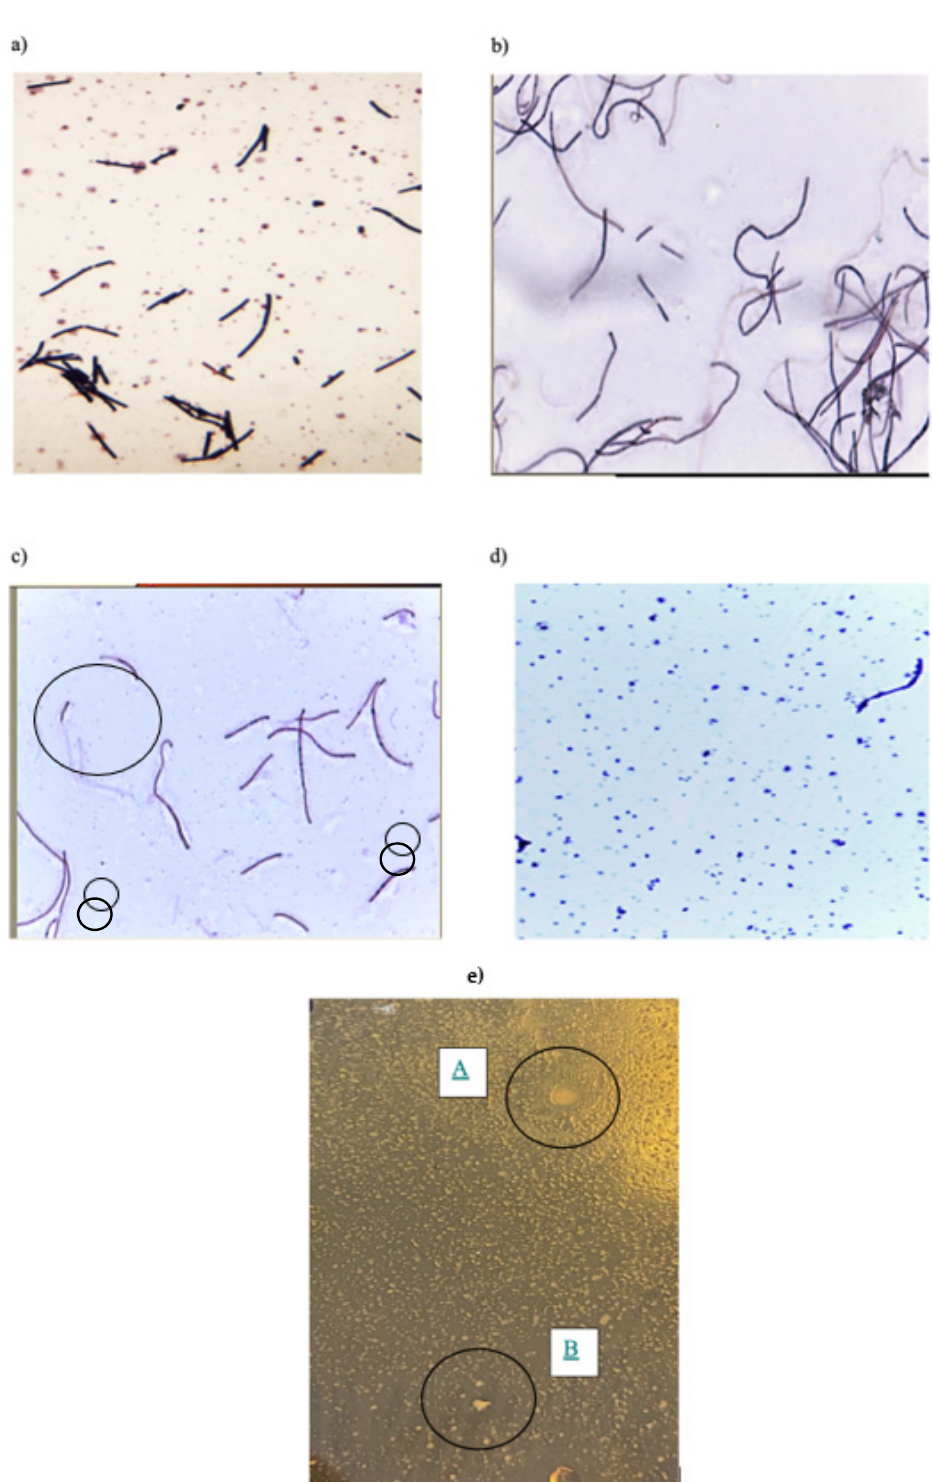
Figure 2. Microscope images (×1000 magnification) of Gram-stained L. bulgaricus . ( a ) Pure L. bulgaricus strain incubated at 42 °C, showing short and rod shape. ( b ) Thermo-tolerant strain of L. bulgaricus incubated at 52 °C, showing elongated shape. ( c ) First incubation at 52 °C after storing at − 80 °C for 3 weeks, showing truncation in elongated cells and formation of cocci. ( d ) Post to three rounds of sub-culturing at 52 °C, showing further transformation of truncated elongated rod-shaped cells (from ( c )) into cocci. ( e ) Colony A and B are examples of L. bulgaricus showing irregular edges at 52 °C.